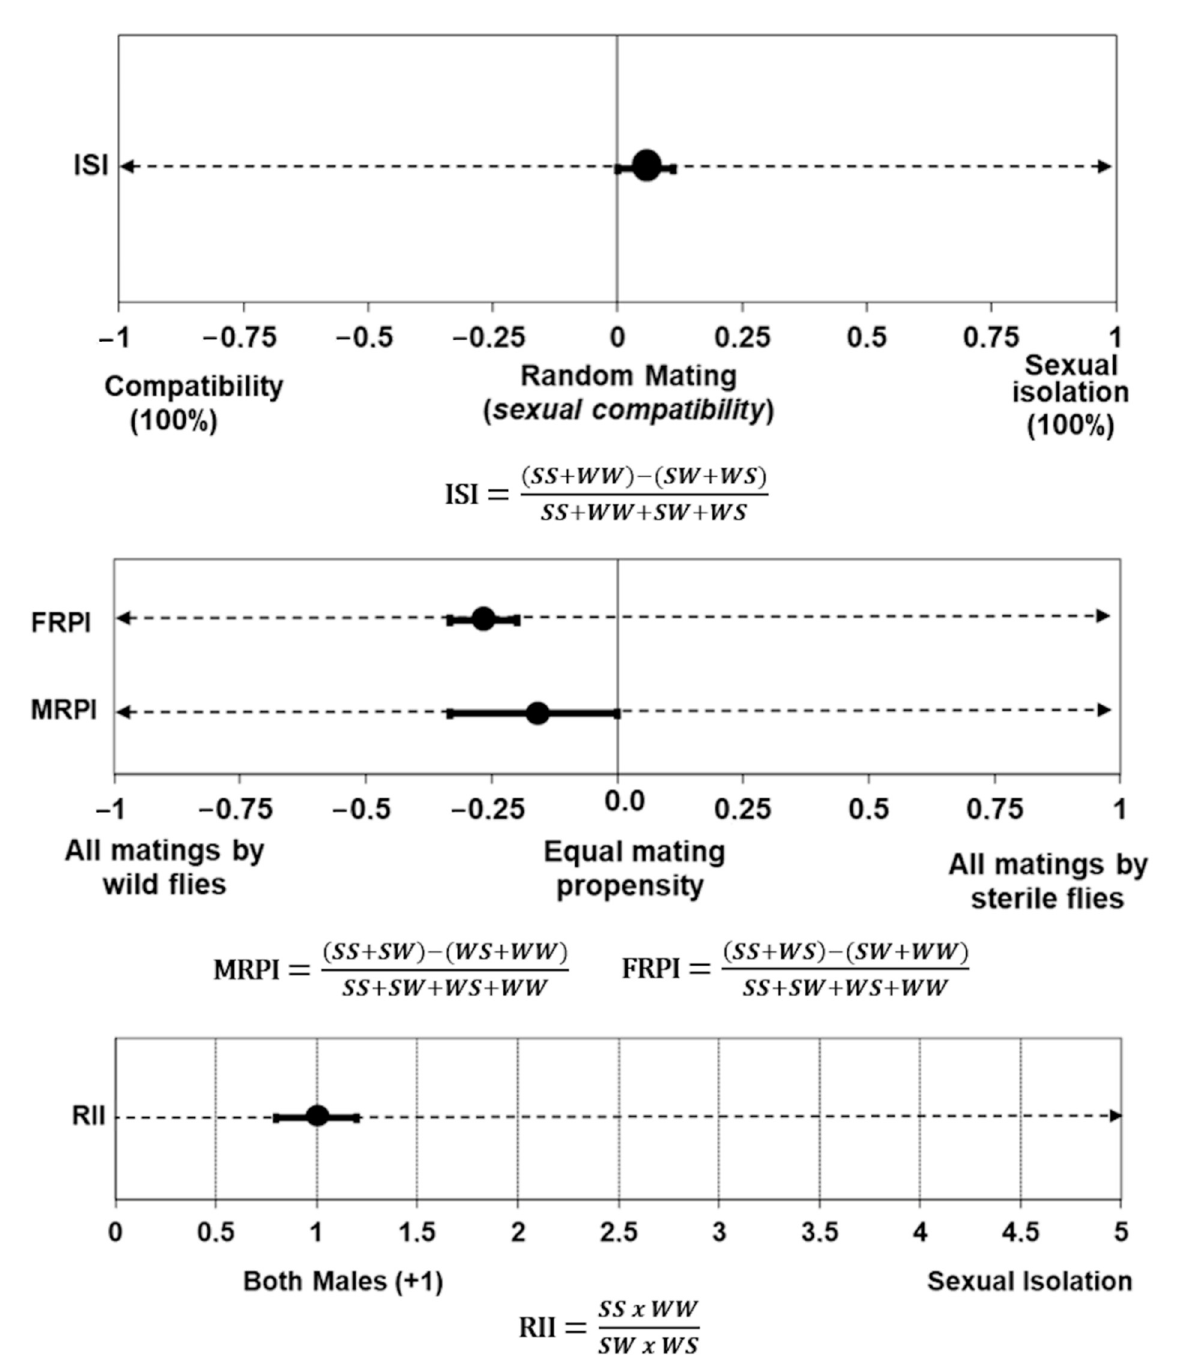
Figure 4. Indices of mating compatibility between sterile flies of the Vacaria strain and wild flies of Anastrepha fraterculus (ISI = isolation index; FRPI = female relative performance index; MRPI = male relative performance index; RII = relative isolation index; SS = sterile male and female; WW = wild male and female; SW = sterile male and wild female; WS = wild male and sterile female). Error bars represent the standard errors of means.